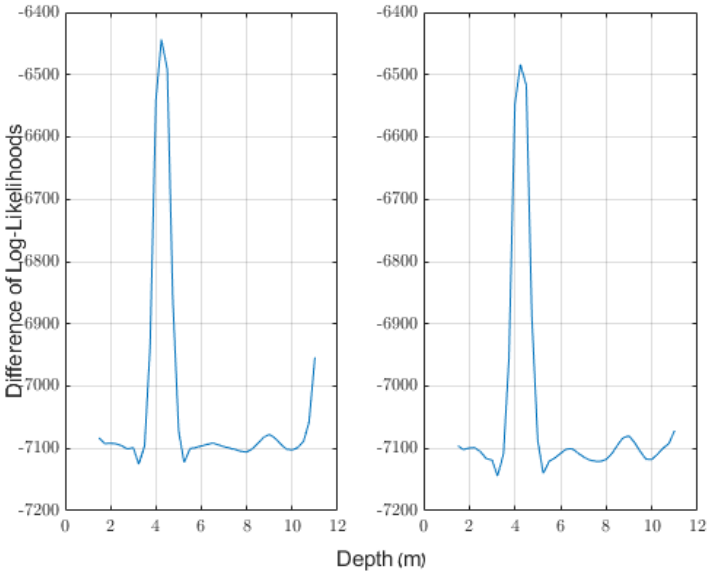
Figure 15. The results of our applying our method to the simulations shown in Figure 14. In both cases we examined the frequency range of 16–80 MHz, used a window size of four depths (one meter), and used a guard distance of two depths (0.5 m). The cavity was assumed to have a width of one